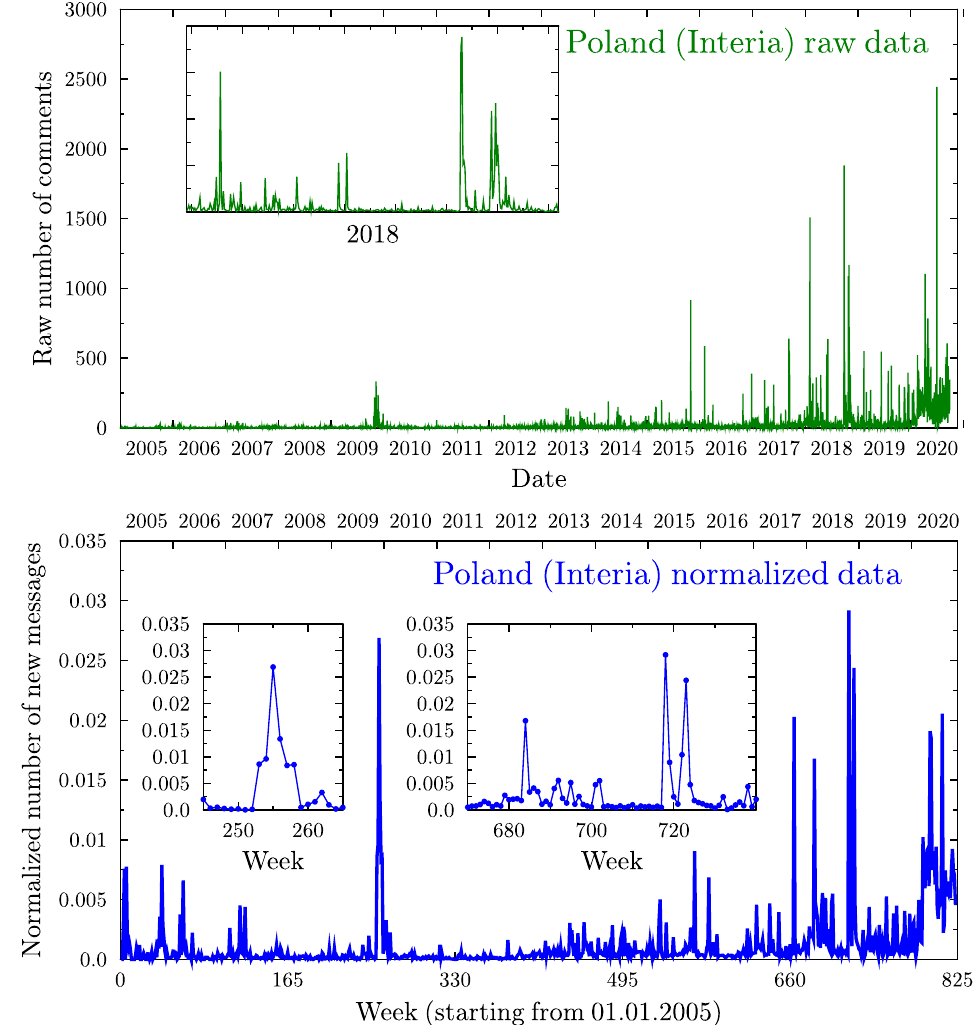
Figure 2. ( Upper panel ): Daily number of new user comments related to vaccination in the Interia dataset, as given by the keyword search algorithms. ( Lower panel ): Normalized number of new user comments appearing on the Interia Web page related to vaccination each week. Because the general traffic at the site has been steadily increasing since 2005, the weekly vaccination related message number is normalized to the smoothed total number of comments at a given time. This allows the number to be compared with the model (which assumes a constant volume of agents and